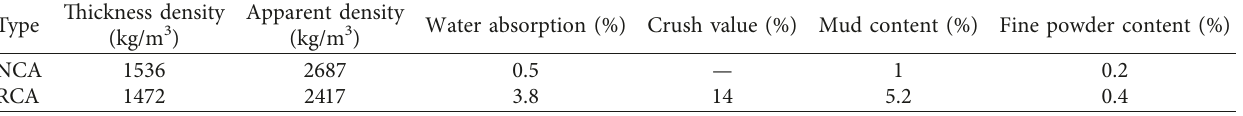
Table 2: Properties of coarse aggregate.